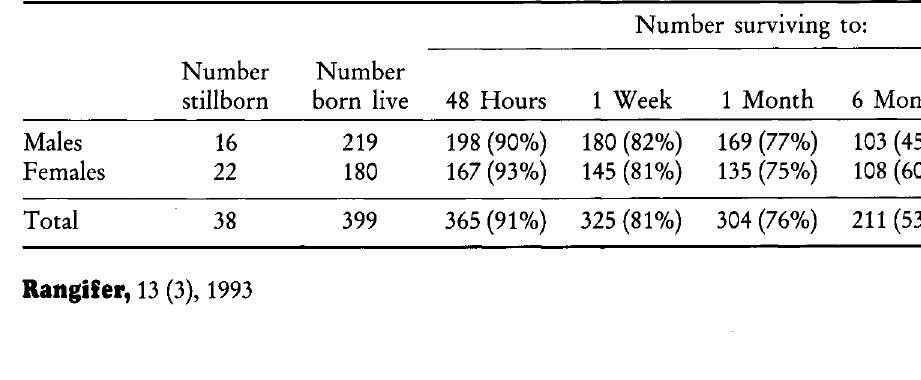
Table 1. Survival rates among captive-born muskoxen. Percent surviving of those born live in